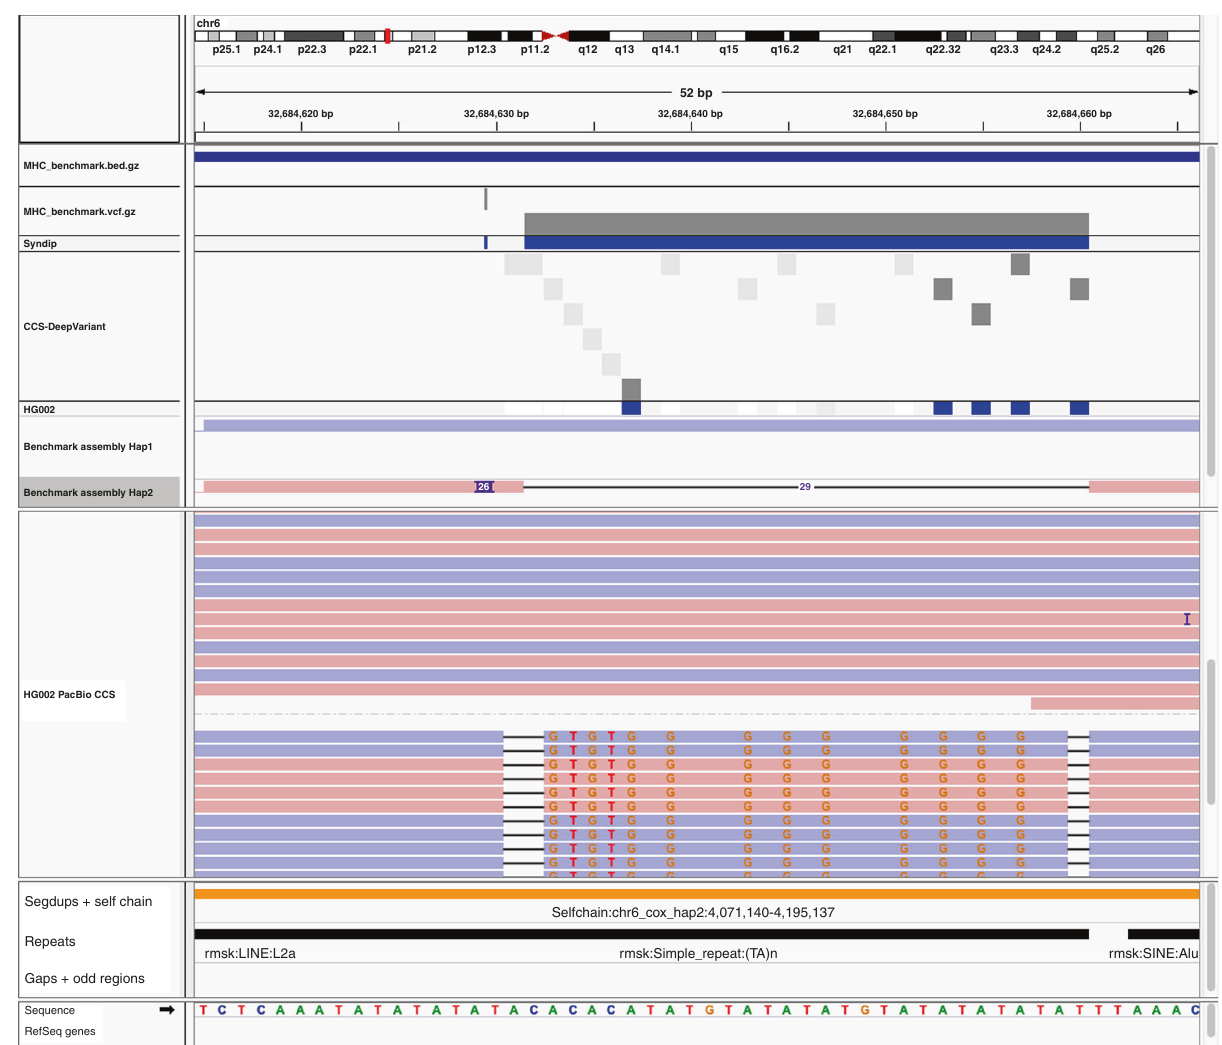
Fig. 4 Example of partially called complex variant counted as both false positives and false negatives. The CCS-DeepVariant VCF from PacBio HiFi reads incorrectly fi lters the 2-bp deletion and 9 of the 13 SNVs in the region ( fi ltered variants are light gray boxes). The benchmark correctly calls this complex variant, and represents it as a 26-bp insertion of a TG tandem repeat followed by a 29-bp deletion of adjacent tandem repeats. When comparing this VCF to our MHC benchmark, the benchmark insertion and deletion variants are counted as false negatives, while the 5 SNVs called are counter- intuitively counted as false positives because the other variants are incorrectly fi ltered. If the CCS-DeepVariant VCF had not fi ltered all of the other variants, all variants would be counted as true